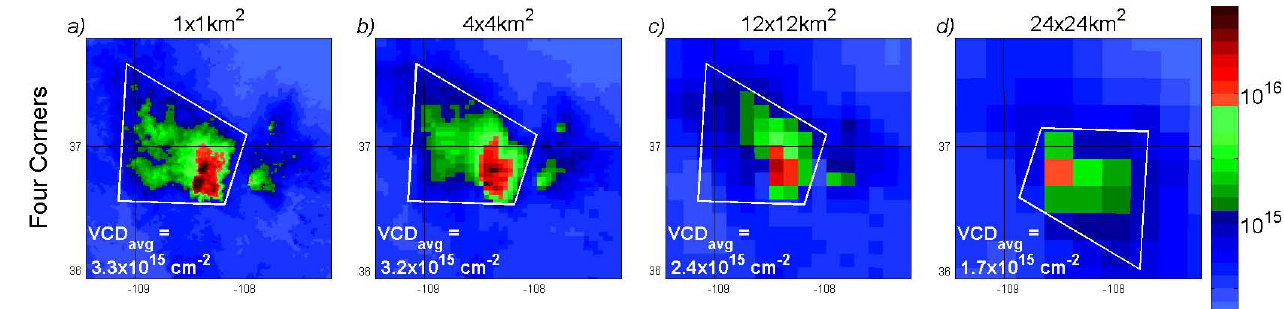
Fig. 7. WRF-CHEM 3–7 July 2006, 1p.m.LST average NO 2 column (moleculescm − 2 ) simulated over Four Corners Region of US at (a) 1km, (b) 4km, (c) 12km, and (d) 24km model resolution. NO 2 column is averaged over a sub-domain (white box) and reported in the bottom left corner of each panel. The sub-domain in the 24km simulation was rotated to include the plume, which was predicted further to the SE than those predicted at 1, 4, or 12km resolution.